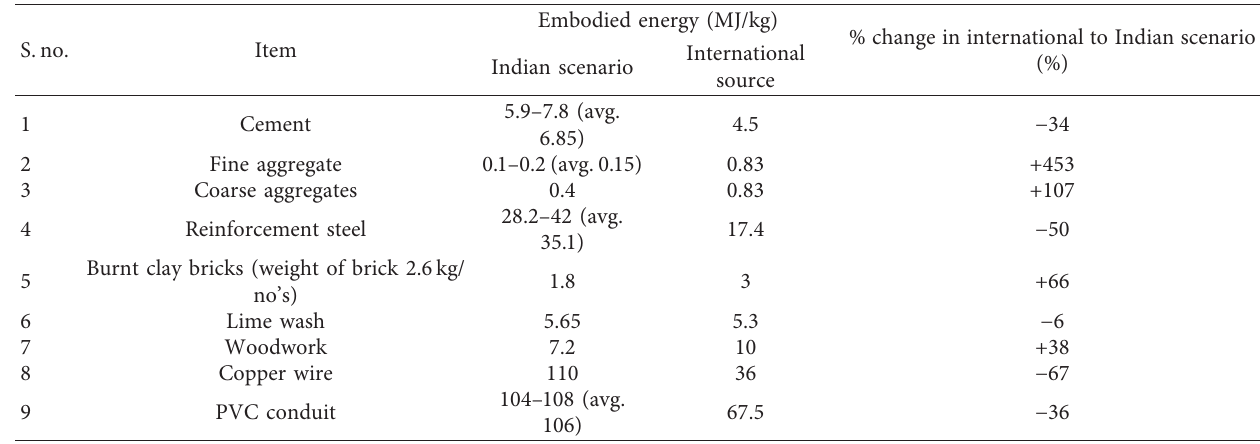
Table 4: Embodied energies of construction materials [9, 46–48, 51].